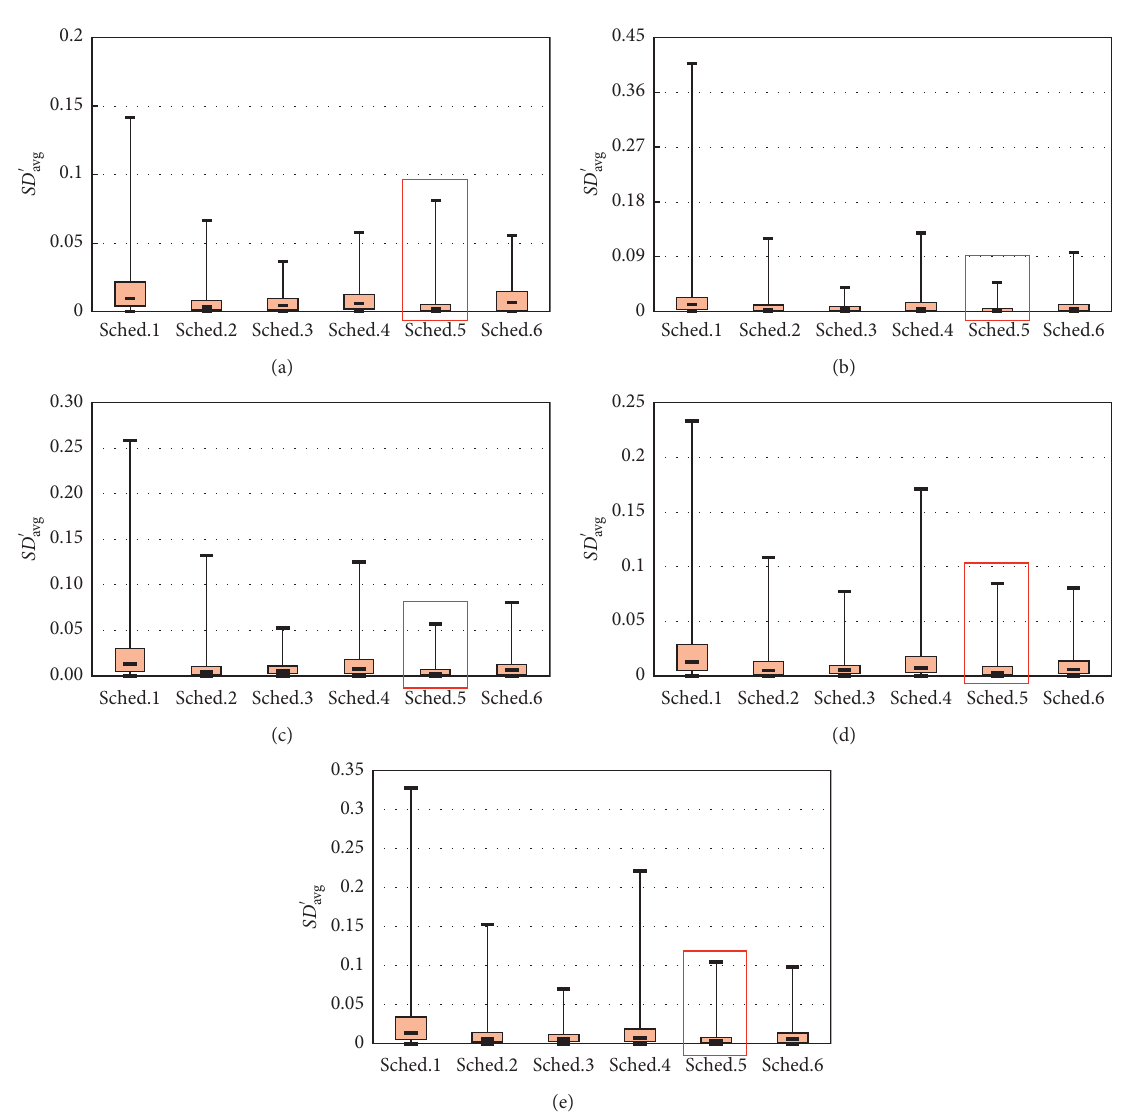
Figure 6: Schedule robustness of different nominal left-turn paths. (a) 500veh/h/lane. (b) 600 veh/h/lane. (c) 700veh/h/lane. (d) 800veh/h/ lane. (e)